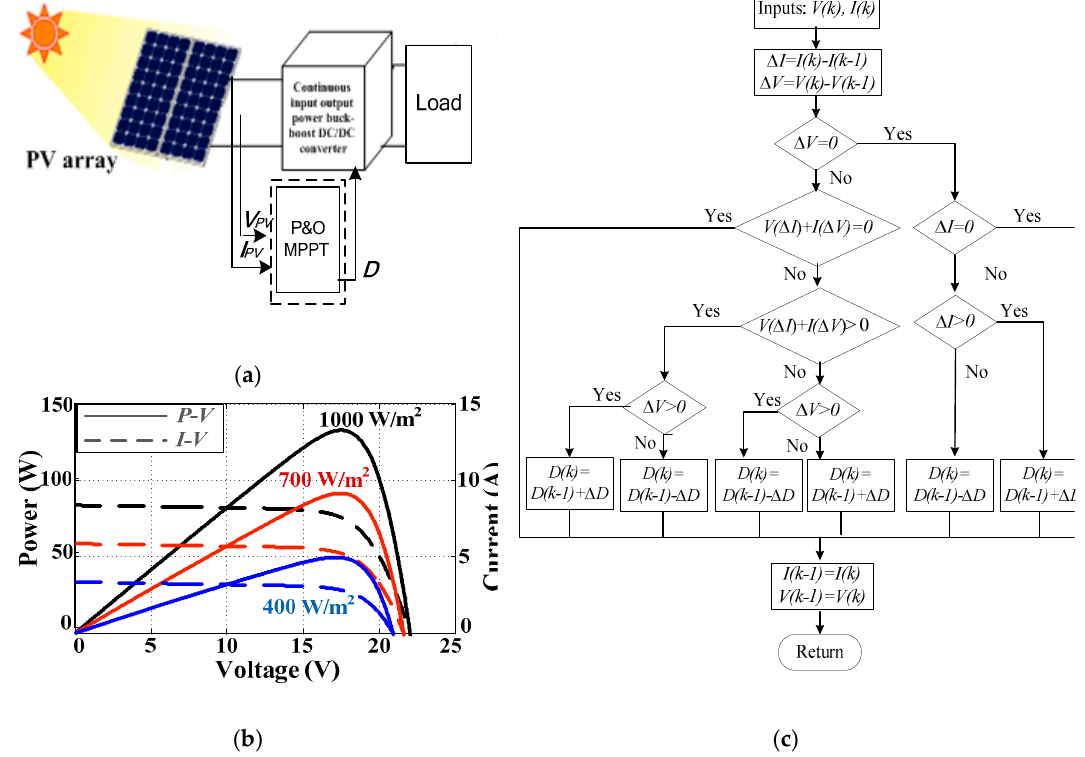
Figure 3. Considered system for simulation: ( a ) block diagram; ( b ) I-V and P-V curves of the simulated photovoltaic (PV) panel under different irradiance levels; ( c ) flowchart of the applied modified Inc. Cond. algorithm [9].